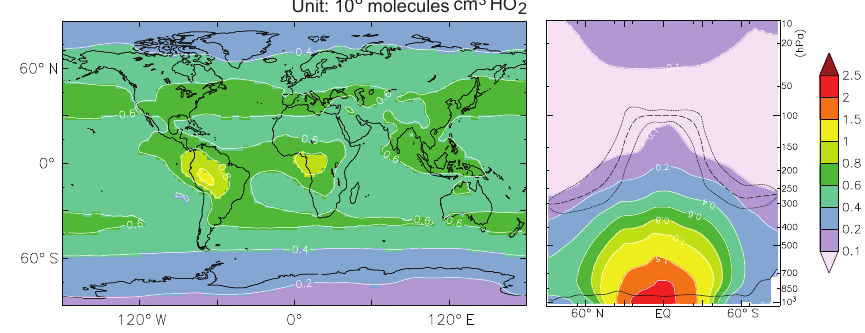
Figure 3. As Fig. 1 but for HO 2 in 10 8 moleculescm − 3 in the troposphere (left) and up to 10hPa (right).